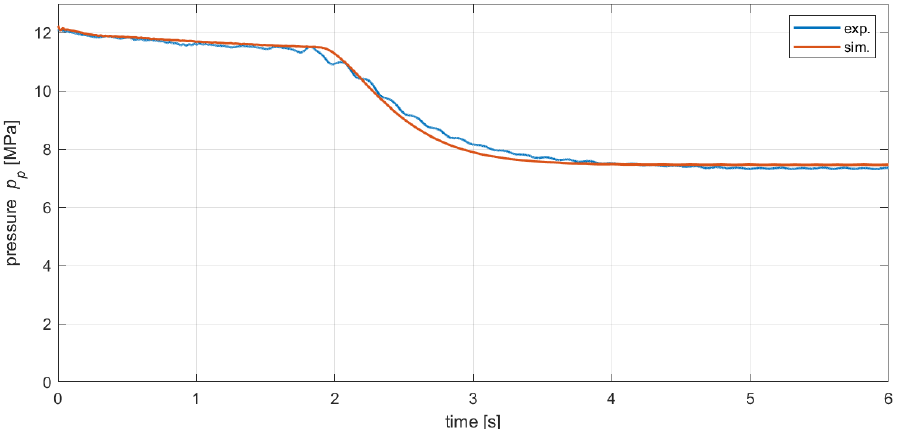
Figure 16. Measurement and result of simulation of the waveform of pressure on the pump 𝑝 (cid:3043) for the control signal rise time 𝑡 (cid:2868) = 1 s .